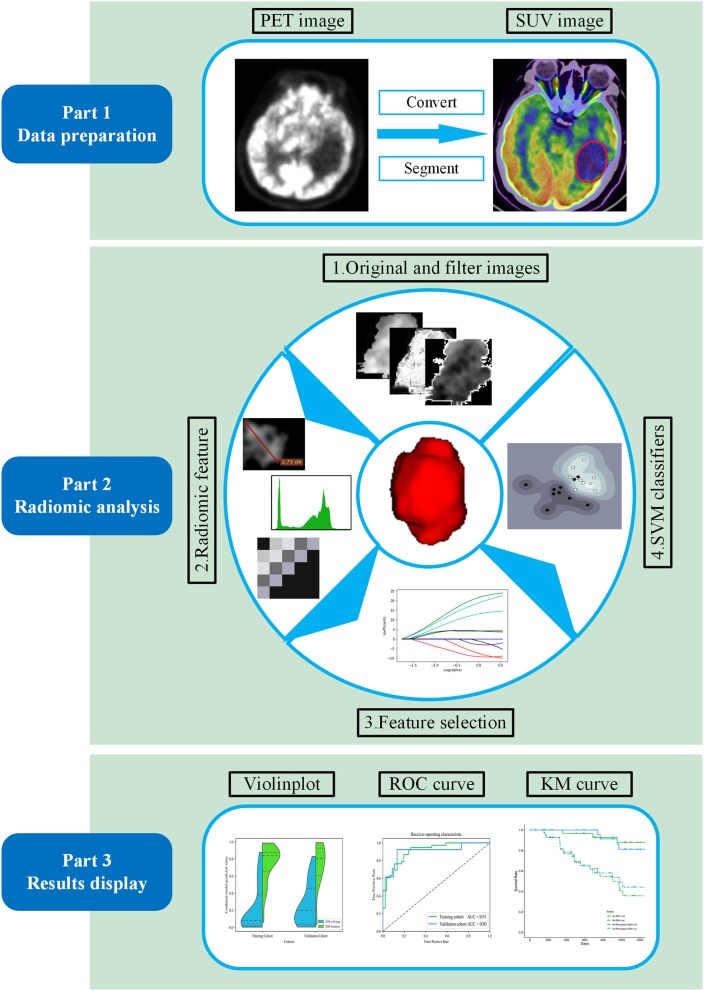
Workflow of the proposed radiomic analysis for non-invasively predicting isocitrate dehydrogenase (IDH) genotype and prognosis in glioma patients.